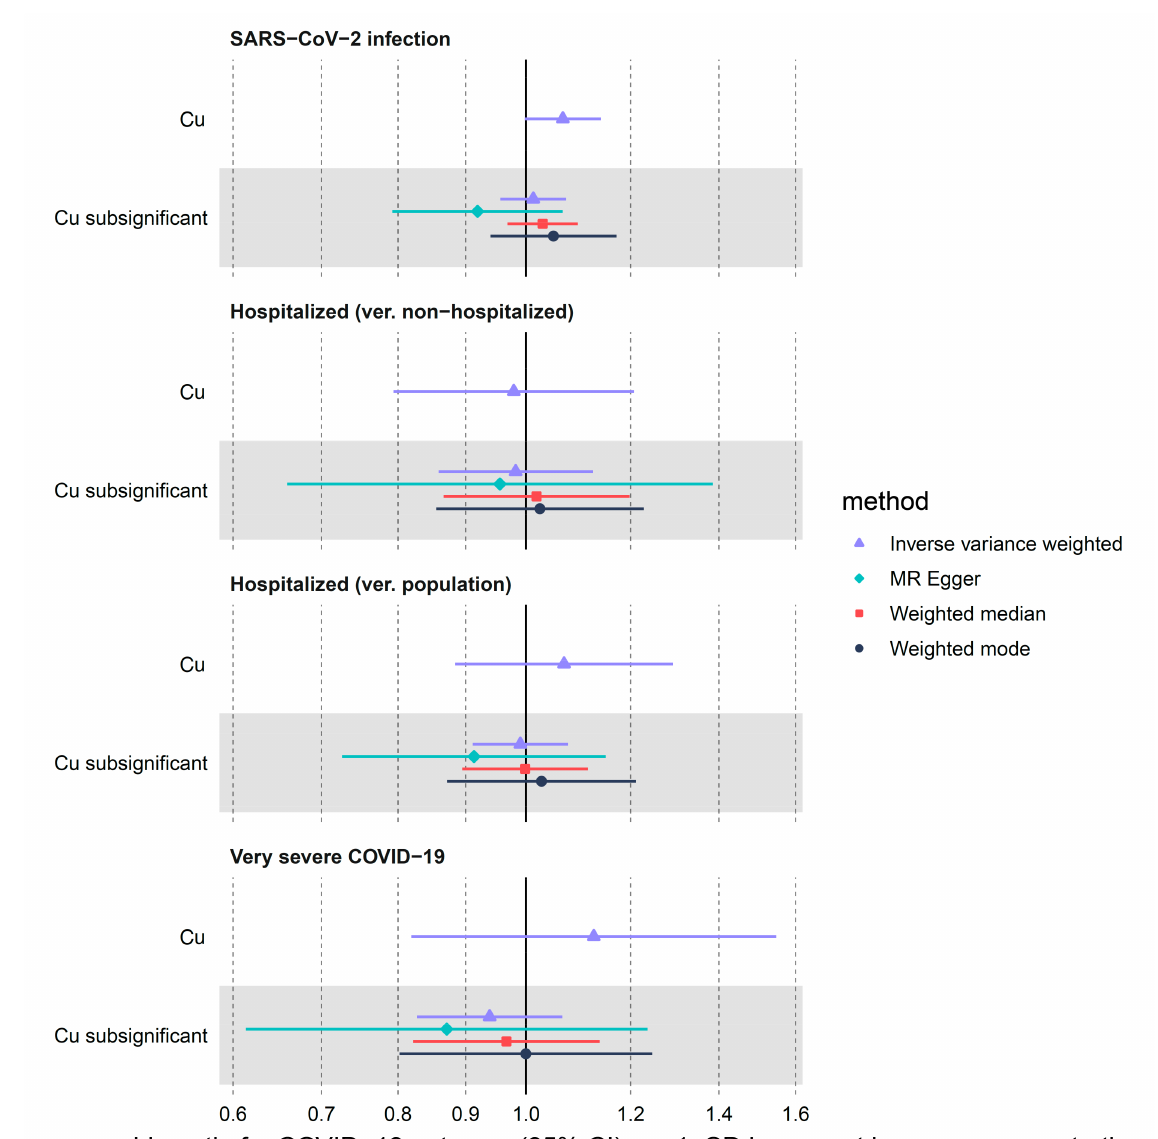
Figure 3. MR estimates for the effect of circulating copper (Cu) on three COVID-19 outcomes obtained using 4 different statistical methods. We used the following two sets of copper instruments: Cu refers to instruments with p -values < 5 × 10 − 8 and sub-significant Cu refers to instruments with p -values < 5 × 10 − 5